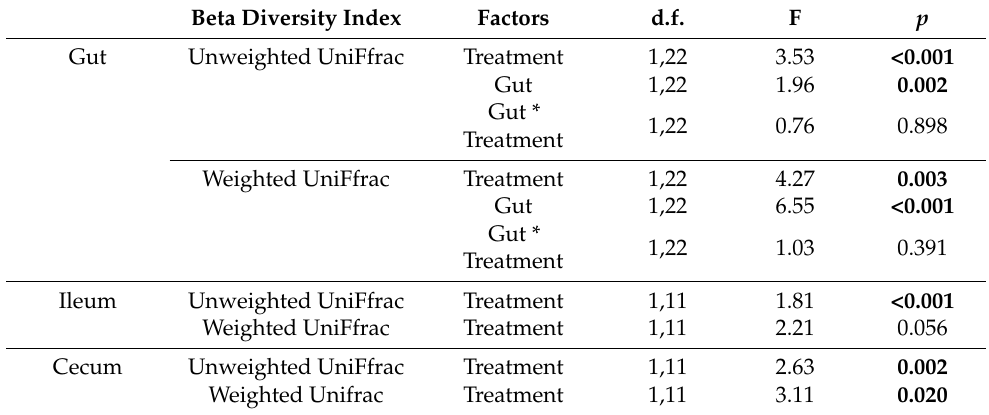
Table 3. General Linear Models exploring the effects of 30-days treatment in beta diversity indexes in ileum and cecum of laying hens. Treated hens received a basal diet supplemented with a commercial Alliaceae extract. Significant values were set at 0.05, which are in bold. Degrees of freedom (d.f.) are also shown. * means interaction